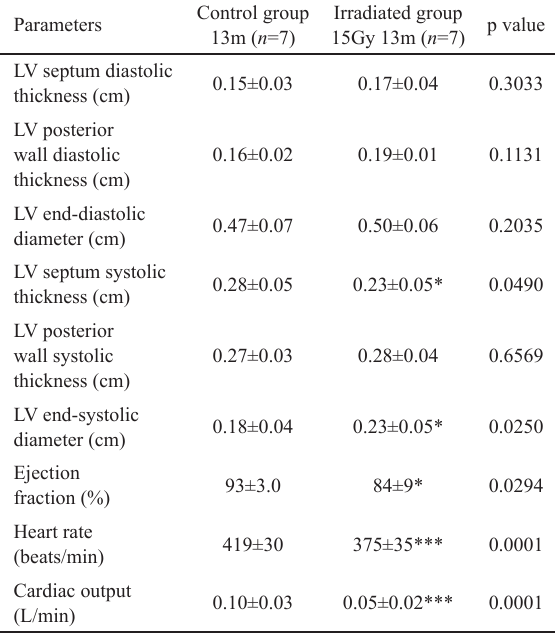
Effect of single dose irradiation (15 Gy) on cardiac examinations using